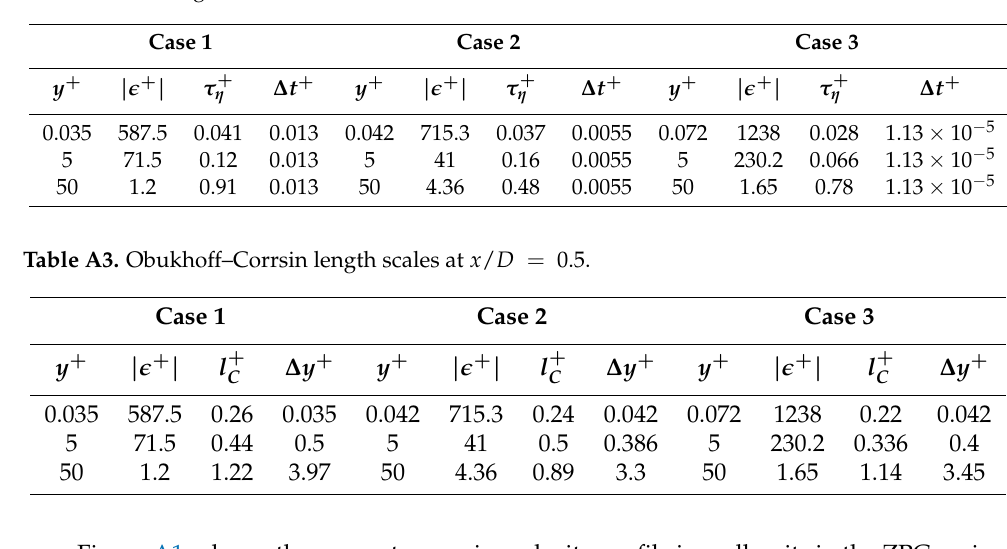
Table A2. Kolmogorov time scales at x / D = 0.5.